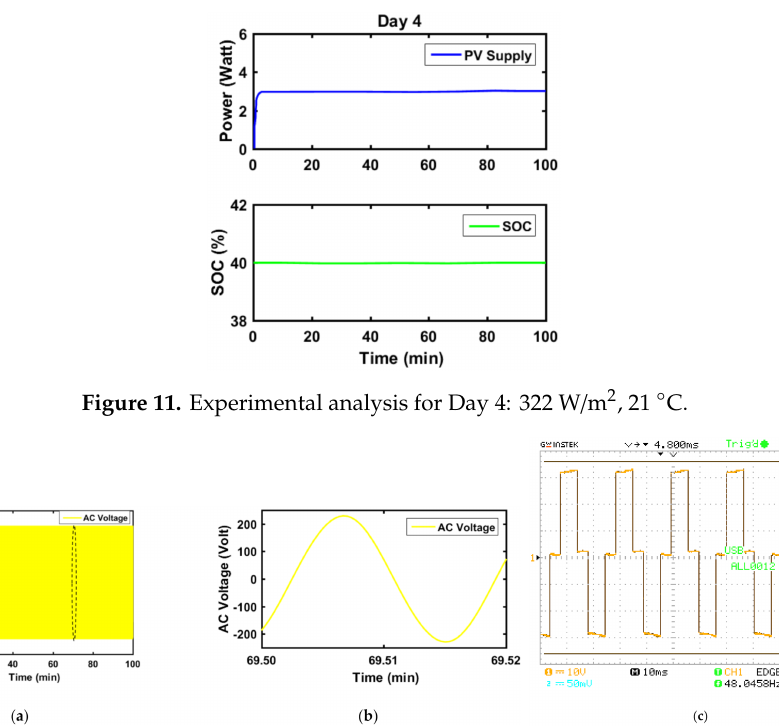
Figure 10. Experimental analysis for Day 3: 372 W / m 2 , 23 ◦ C.